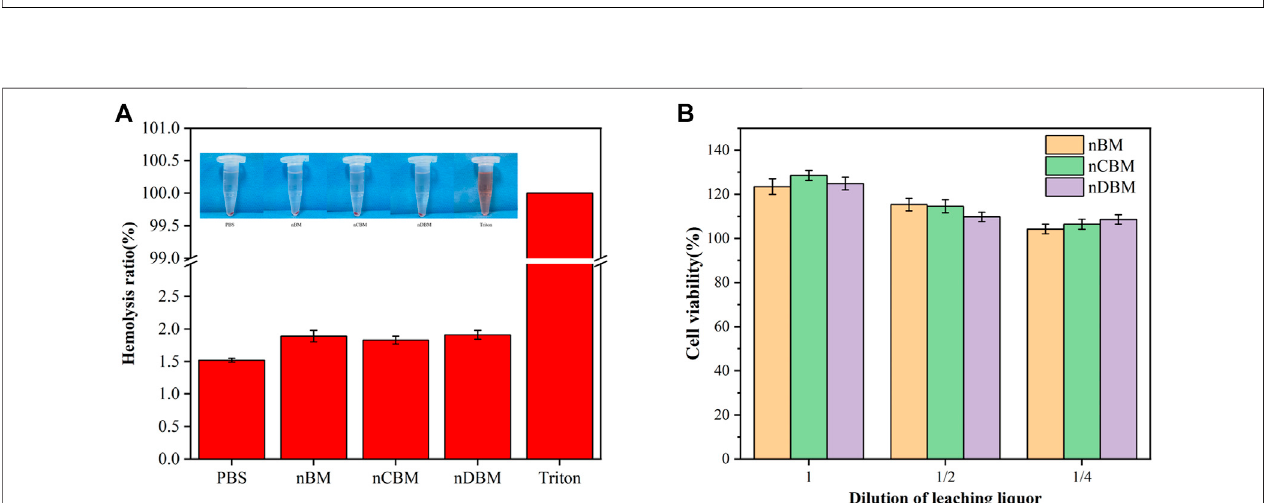
FIGURE 8 | Hemolysis rate (A) and cytotoxicity (B) of different bone powders.